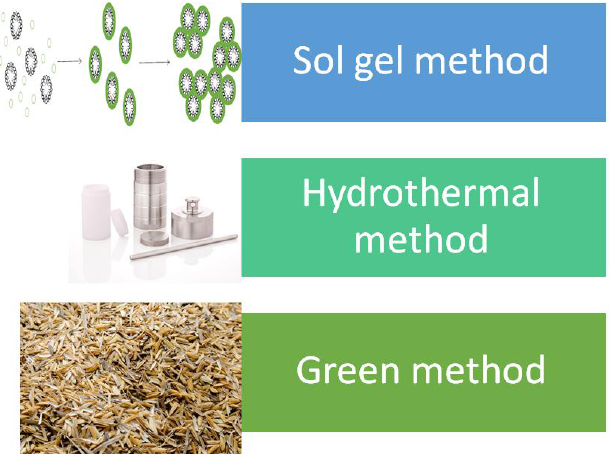
Figure 1. Common techniques in mesoporous silica nanoparticles (MSNs) synthesis. Table 1. Summary of technique in MSNs